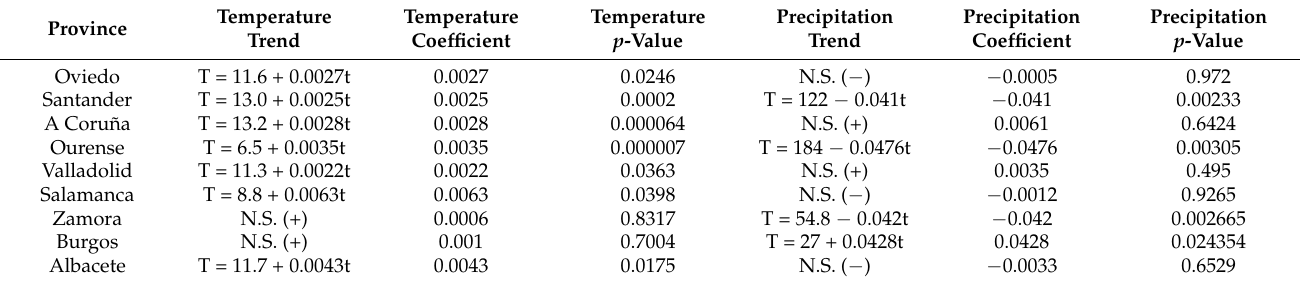
Table 2. Summary of results of the trend analysis for the temperature and precipitation series.